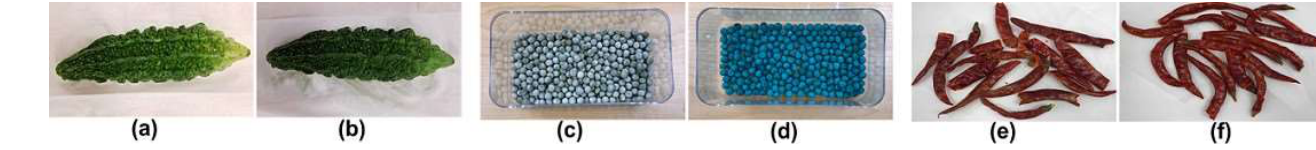
Figure 5. Comparison between the raw and dyed vegetables: ( a ) raw okra, ( b ) okra dyed with copper sulfate, ( c ) raw peas, ( d ) peas dyed with malachite green, ( e ) raw red chilies, and ( f ) red chilies dyed with Sudan red.